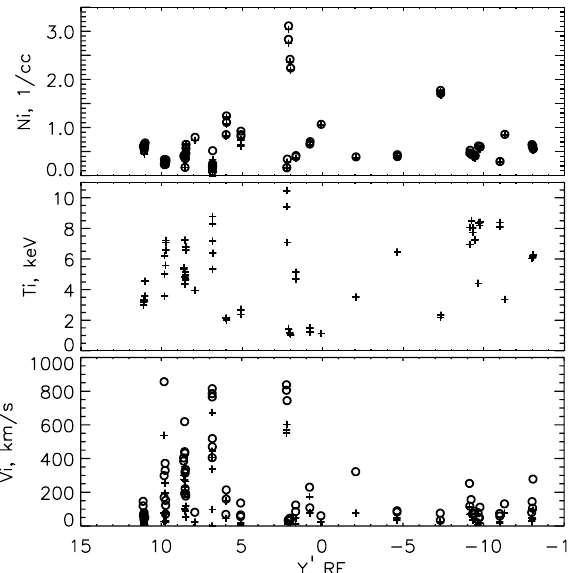
Fig. 4. Distributions of average ion density ( N H + : crosses, N H + + N O + : circles, upper panel), H + temperature (mid panel), average (crosses) and maximal (circles) horizontal velocities ( V xy ) for each selected crossing versus Y 0 .